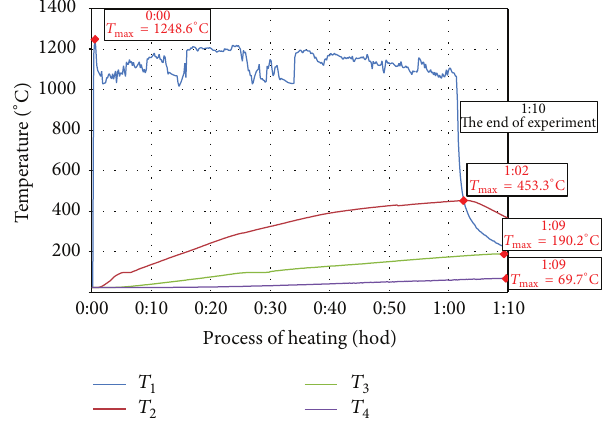
Figure 5: Record of thermal development of the test specimen CEM III/B - B.